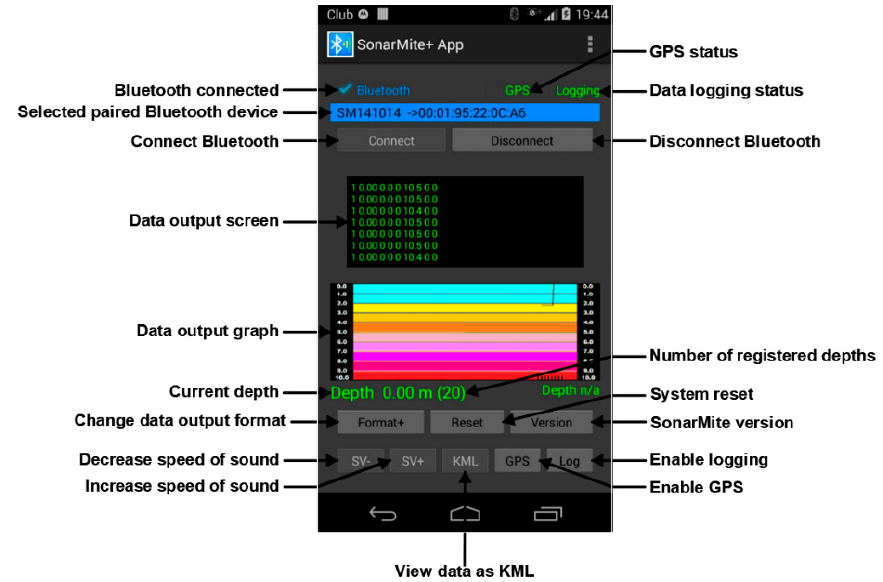
Figure 9. The application window for setting the calibration velocity of a single beam echo sounder (SBES) displaying the results of depth measurements.